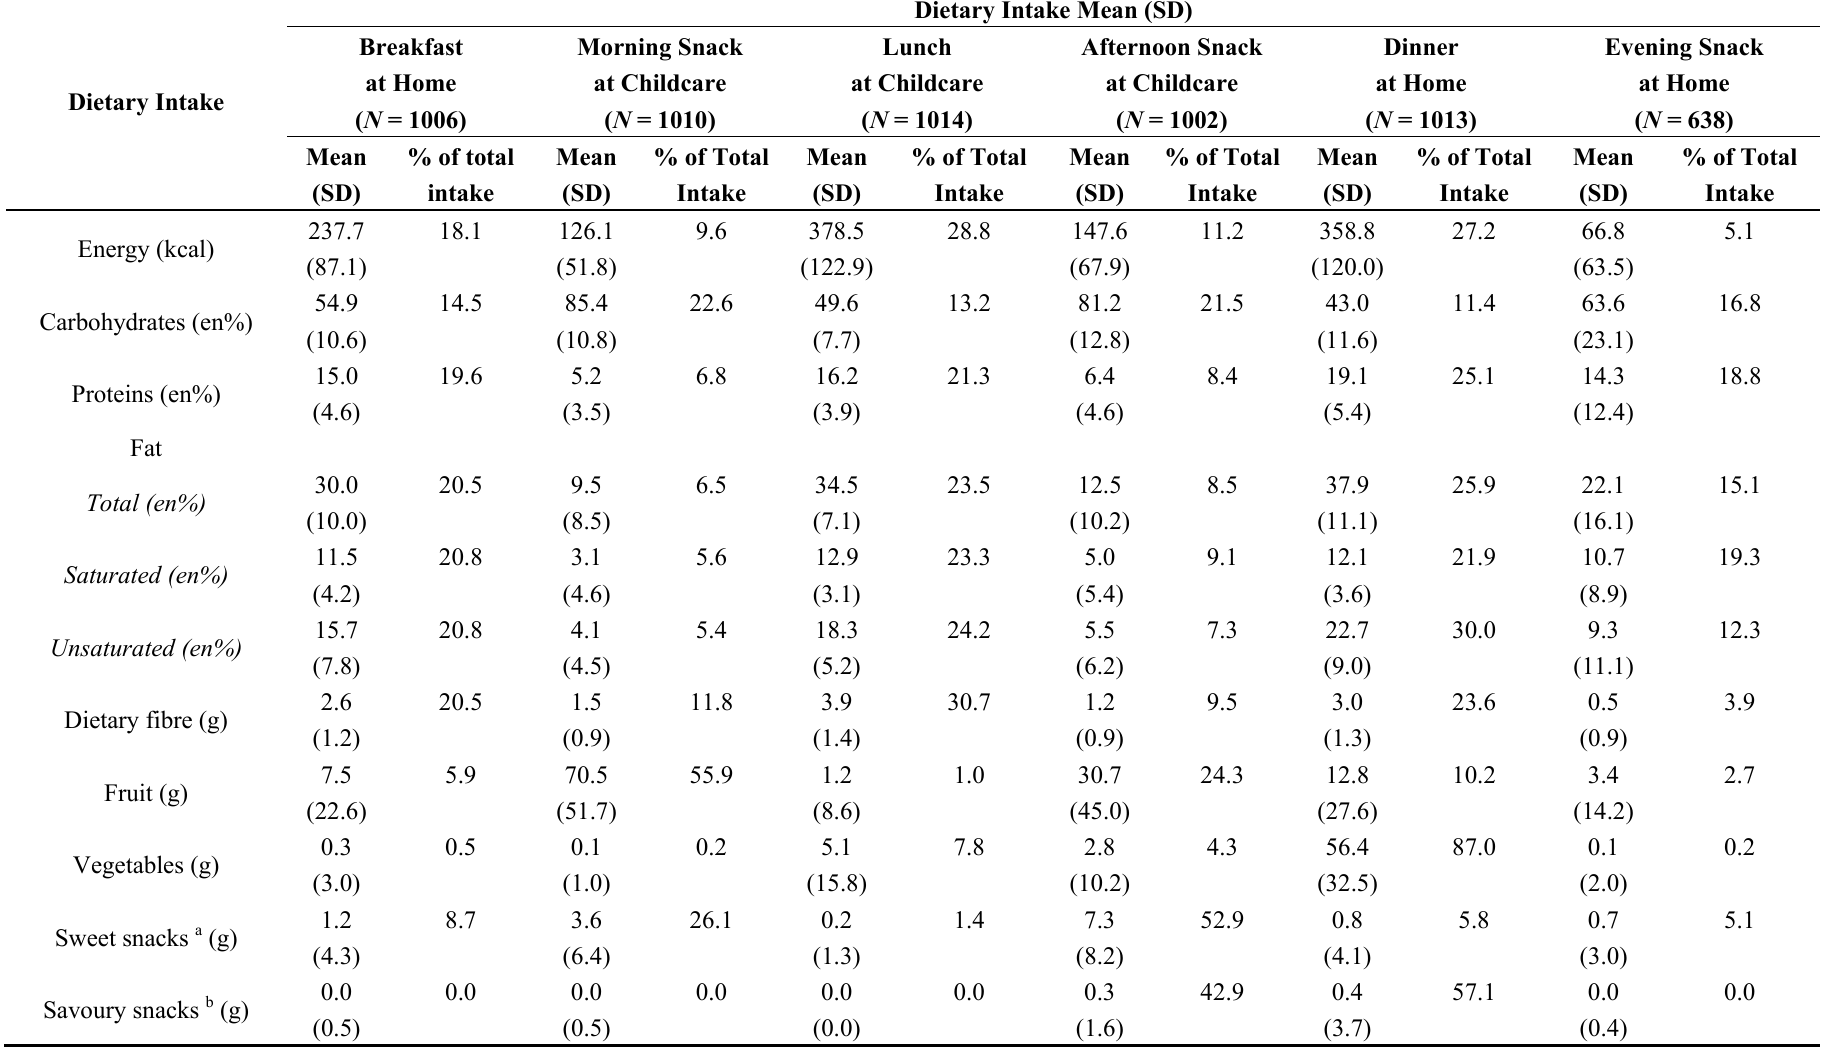
Table 3. Dietary intake by toddlers at different eating